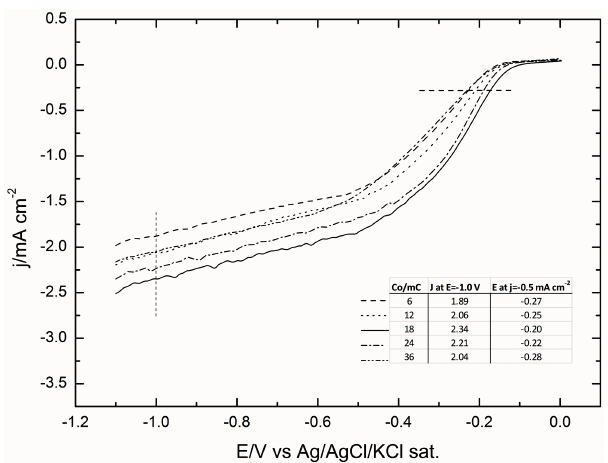
Figure 3. Oxygen reduction reaction (ORR) in KOH 0.1 M on glassy carbon (GC) covered by increasing amounts of Co from 6 mC–36 mC recorded at 500 rpm and with a scan rate of 50 mV·s − 1 .